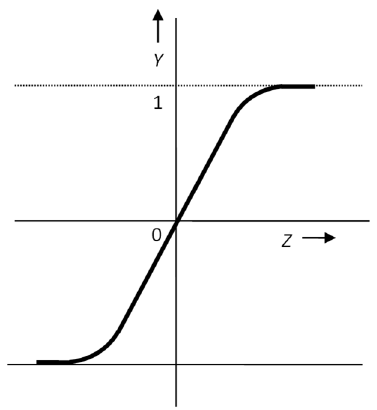
Figure 6. Hyperbolic tangent.